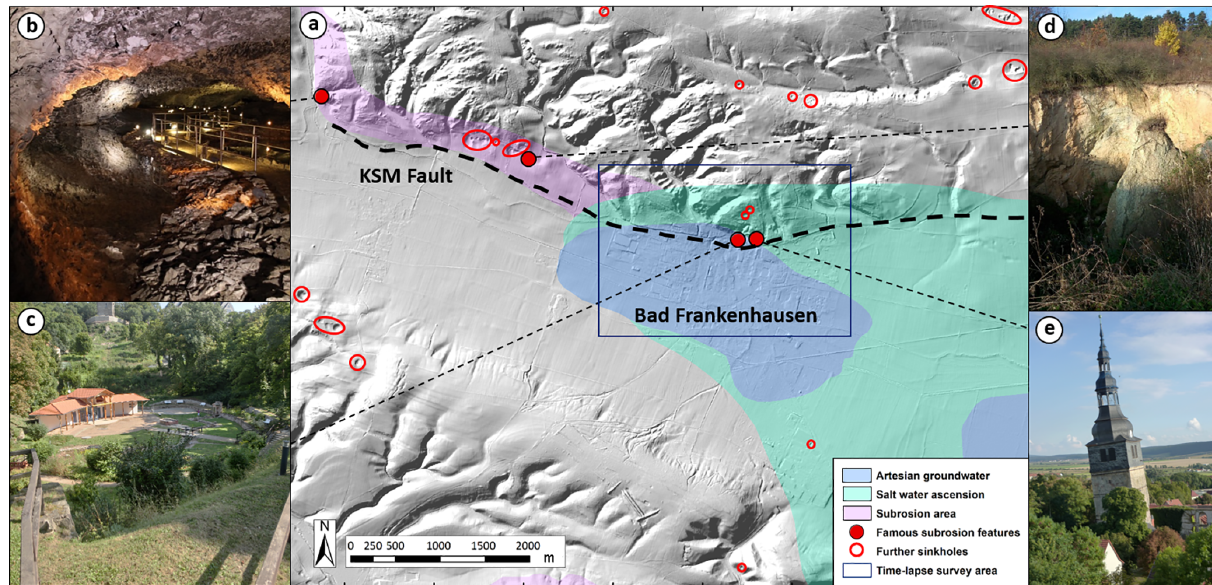
Figure 2. Subrosion features in Bad Frankenhausen (BF) and its surroundings. (a) Digital elevation model and the colour-coded hydroge- ological assessment of BF and its surroundings (provided by Thuringian State Institute of Environment and Geology, 2016; Sven Schmidt, personal communication, 2016; same map extent as in Fig. 1). Salt water ascension and artesian groundwater conditions affect the survey area (dark blue rectangle). Along the Kyffhäuser Southern Margin Fault (KSM Fault; bold dashed line), a potential fluid path, and thus a sub- rosion area, several sinkholes (red circles), as well as famous subrosion features occur (filled red circles; see panels b – e ; sketch after Wadas et al., 2016). (b) Barbarossa Cave (detected in 1865) as part of an educational trail showing karst features along the subrosion area. (c) The oldest sinkhole, Quellgrund (first mentioned in 998AD; collapsed for several times and for the last time in 1908; depth now is approximately 10m), in the centre of the survey area comprises two natural brines with salinities of 4% and 9.8%. (d) One of the most recent sinkholes (collapsed in 2009), in a field beside the largest sinkhole of the region, the Äbtissingrube. (e) The leaning church tower of BF (inclination: 4.93 ◦ ) is a very famous subrosion feature and a magnet for